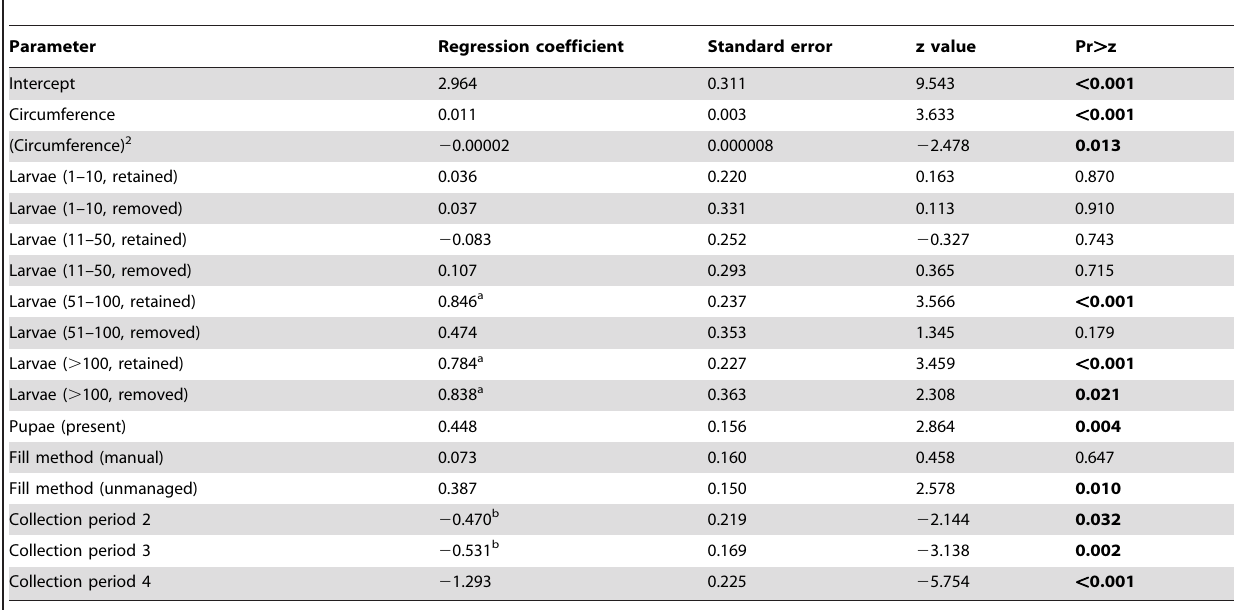
Table 3. Parameter coefficients for negative binomial regression model predicting daily number of Ae. aegypti eggs laid (n= 306